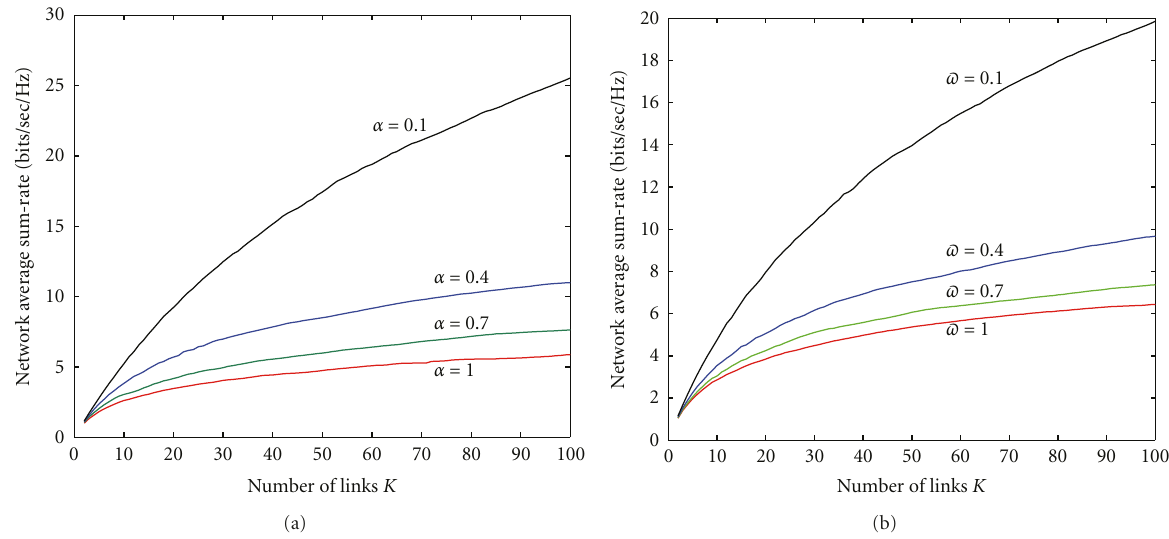
Figure 2: Network average sum-rate versus K for M = 1, (a) shadowing model with (cid:3) = 0 . 5 and variance 1 and α = 1,0 . 7,0 . 4,0 . 1, and b) shadowing model with (cid:3) = 1,0 . 7,0 . 4,0 . 1, variance 1, and α = 0 .